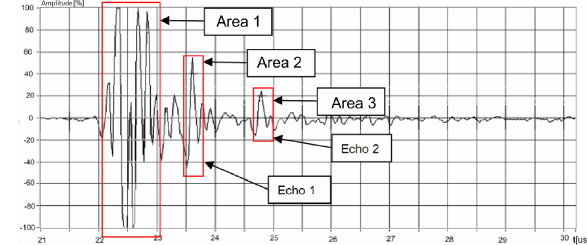
Figure 4: Example of the measurement signal with characteristic areas.